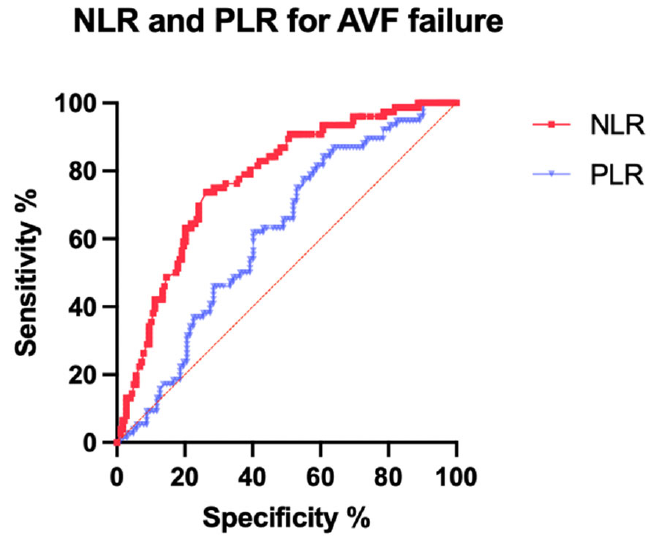
Figure 3. Receiver operator characteristic (ROC) curves. Red curve: NLR for arterio-venous failure; blue curve: PLR for arterio-venous failure.